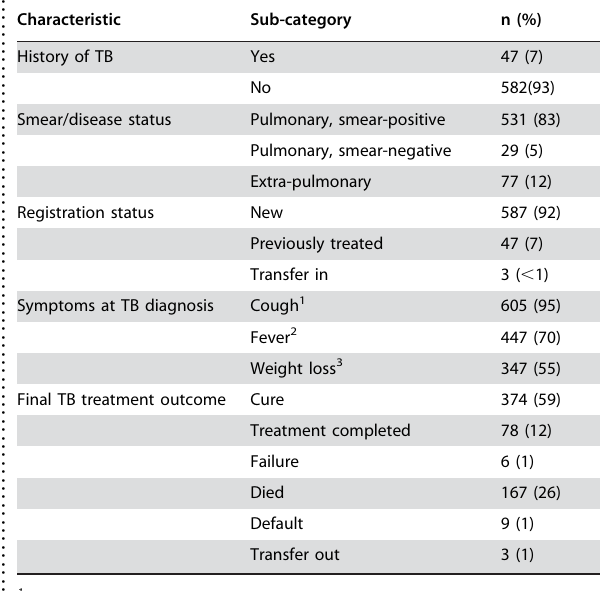
Table 2. Clinical characteristics of HIV-infected TB patients (n=637) – An Giang, Vietnam, 2001 – 2004. .. ... .... ... ... .... ... ... .... ... ... .... ... ... .... ... ... .... ... ... .... .